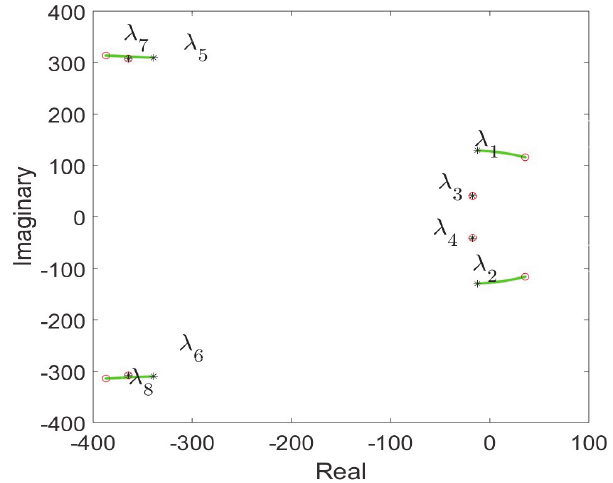
Figure 10. Eigenvalue loci of closed loop system with k i 2 from 1 to 0.1.